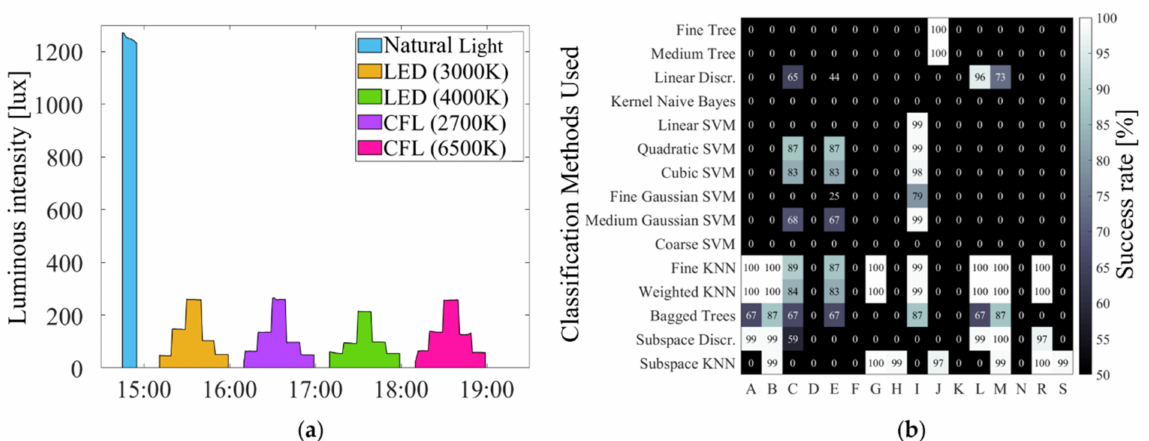
Figure 9. ( a ) Controlled light environment used to create generalization test data for classifiers that passed the training test. ( b ) Classification results using normalization by B value ( B normalization) in a controlled light